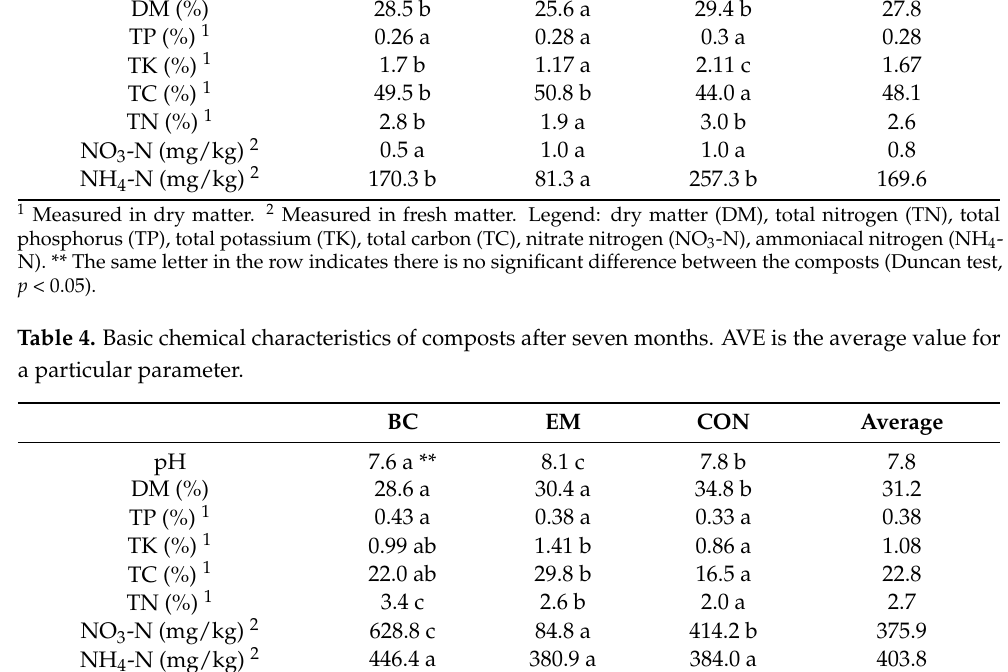
Table 3. Basic chemical characteristics of input material. AVE is the average value of a particular parameter. BC EM CON pH